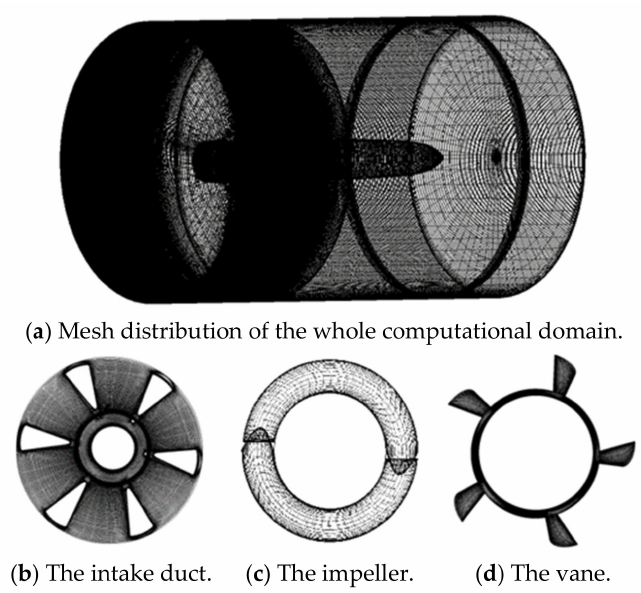
Figure 2. Mesh distribution on the hydraulic components.